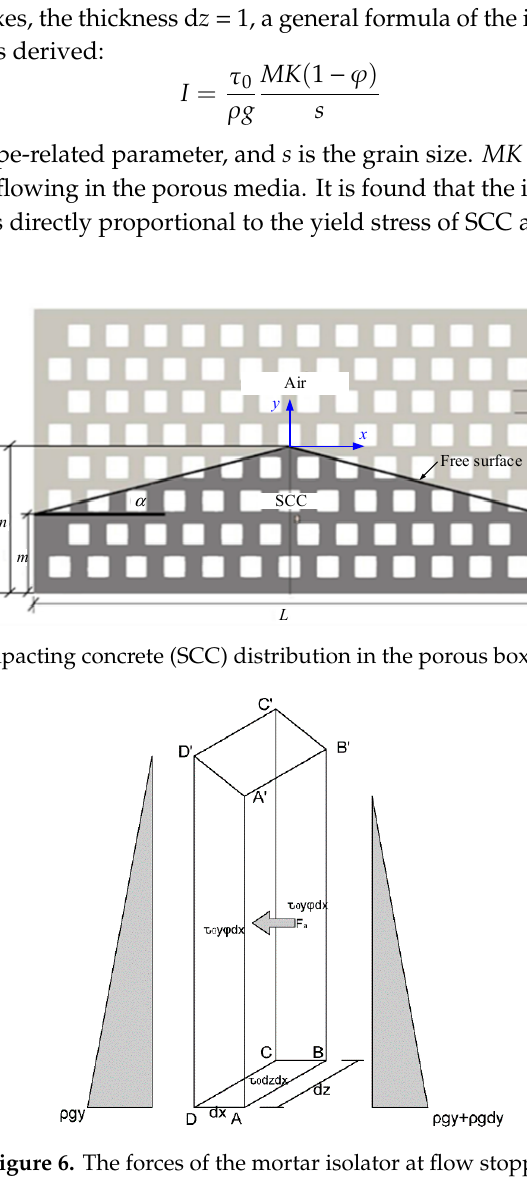
Figure 6. The forces of the mortar isolator at flow stoppage.